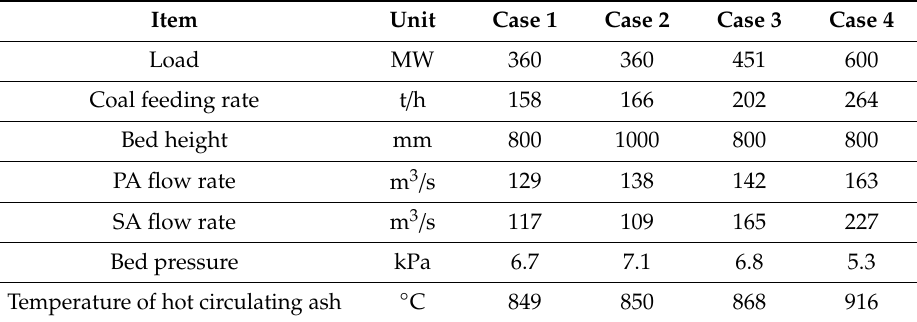
Table 2. Main operating parameters of the boiler during the tests.